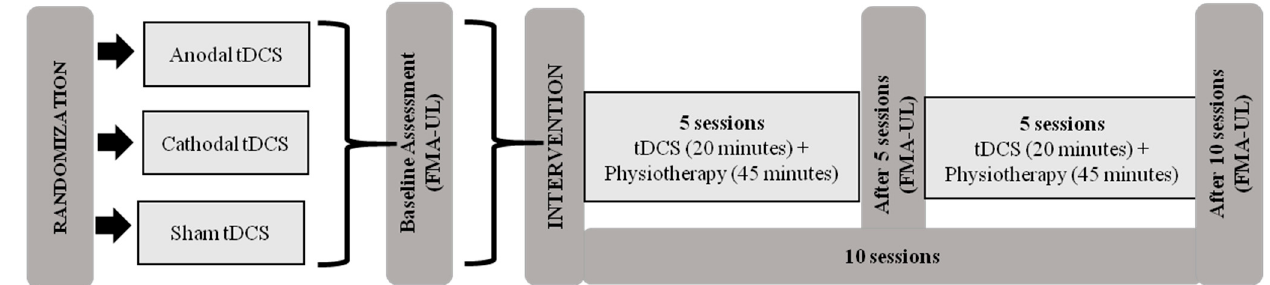
Figure 1. Intervention protocol. Abbreviations: tDCS, transcranial direct current stimulation; FMA-UE, Fugl-Meyer Assessment of Upper Extremity. FMA-UE, Fugl-Meyer Assessment of Upper